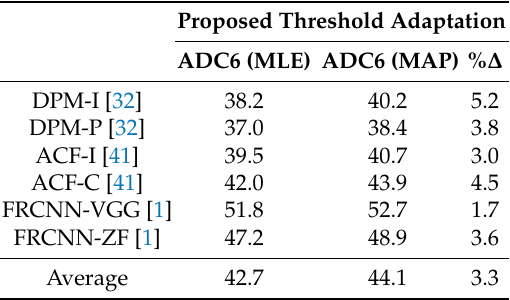
Figure 11. Visual representation of prior distributions of any pair of thresholds configurations. Table 7. ADC6 FScore results including the maximum a posteriori estimation in the threshold hypothesis selection or fine